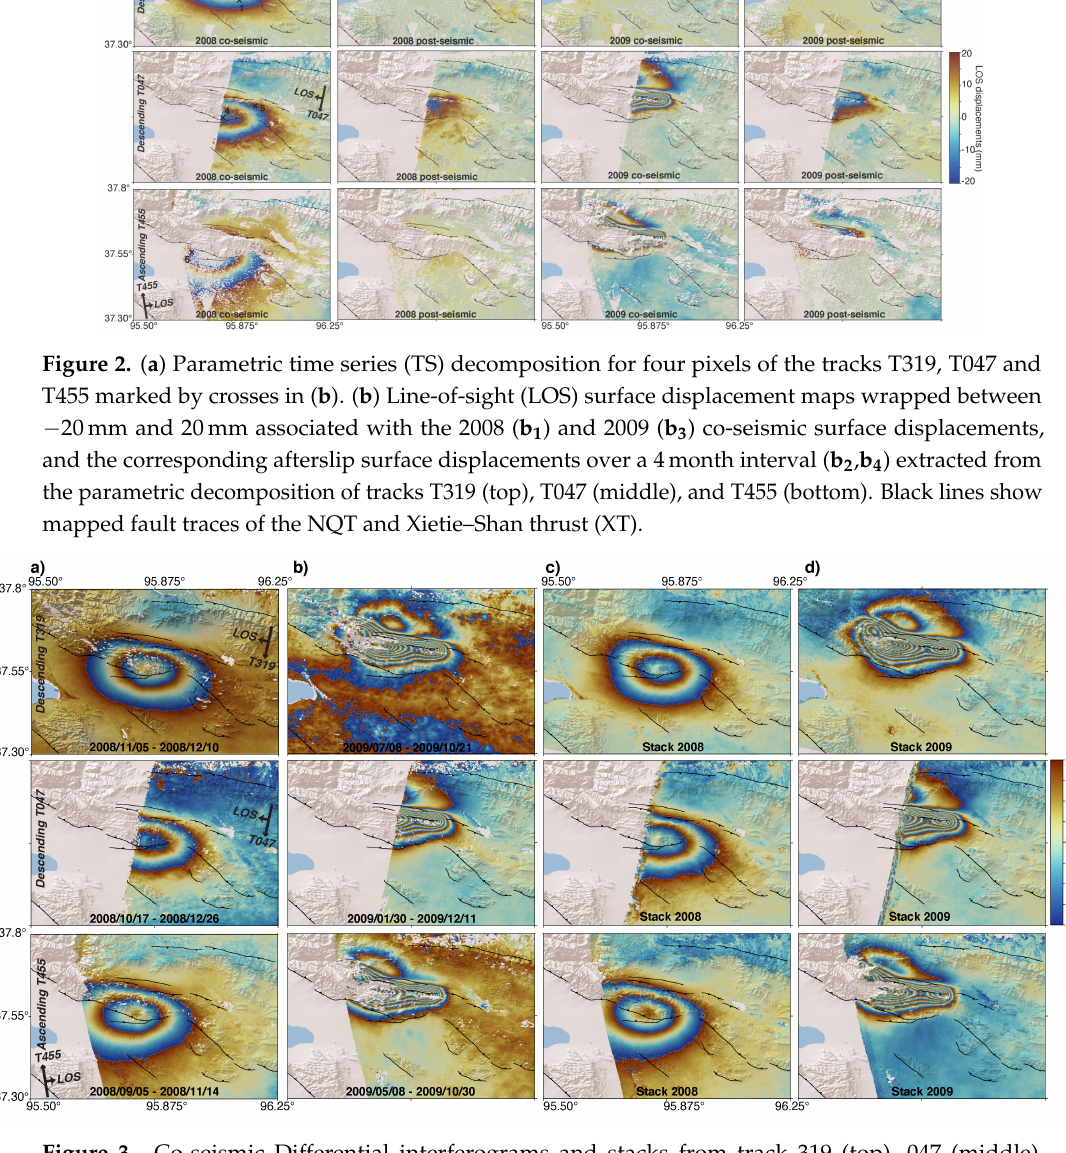
Figure 3. Co-seismic Differential interferograms and stacks from track 319 (top), 047 (middle), 455 (bottom). ( a ) 2008 coseismic Differential interferograms. ( b ) 2009 coseismic Differential interferograms. ( c ) Stack of 2008 coseismic Differential interferograms. ( d ) Stack of 2009 coseismic Differential